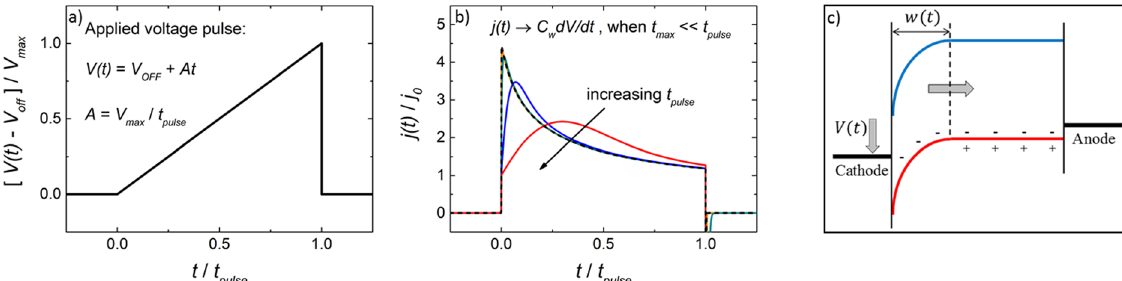
Figure 1. ( a ) A linearly increasing voltage pulse, V ( t ) = V OFF + At , is applied in reverse bias to extract charge carriers at an applied dc voltage V OFF . ( b ) The corresponding current transients j(t) (colored solid lines) are determined by the rate of charge extraction, where the time of the current maximum, t max , depends on the mobility of the extracted carriers and = j C A is the current response due to the geometric capacitance ( C geo ). geo 0 At slow voltage pulses  t t the normalized current transient saturate as → j t j C C ( )/ / (dashed pulse max w geo 0 line), where C w is the depletion layer capacitance. Note that for an accurate evaluation of j ( t ) at slow pulses, the current transients typically have to be corrected for (time-independent) parasitic leakage currents. ( c ) Energy- band diagram at slow voltage pulses where free charges have had time to equilibrate and a depletion region is formed at the cathode, at x = 0, in the case of p-doping. Upon an applied voltage pulse holes are extracted (in the case of p-doping) and the depletion region width, w , increases towards the anode at x = d